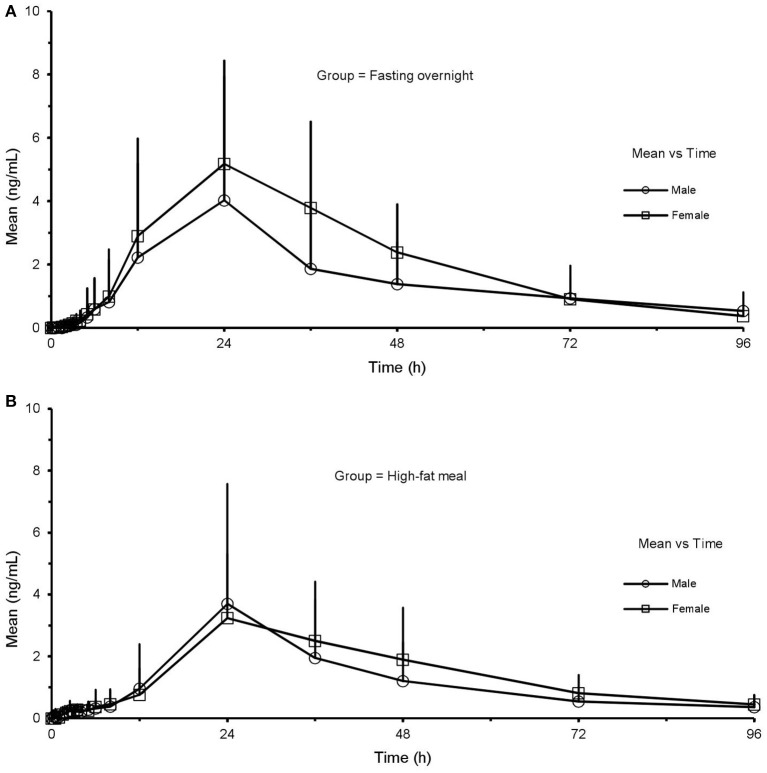
Mean (SD) plasma concentration-time profile of 20(S)-PPD after oral administration of CK 200 mg under fasting overnight (A) and after a high-fat meal (B) in male (n = 12) and female (n = 12) subjects, respectively. CK, compound K; PPD, protopanaxdiol; All values are presented as mean ± standard deviation.